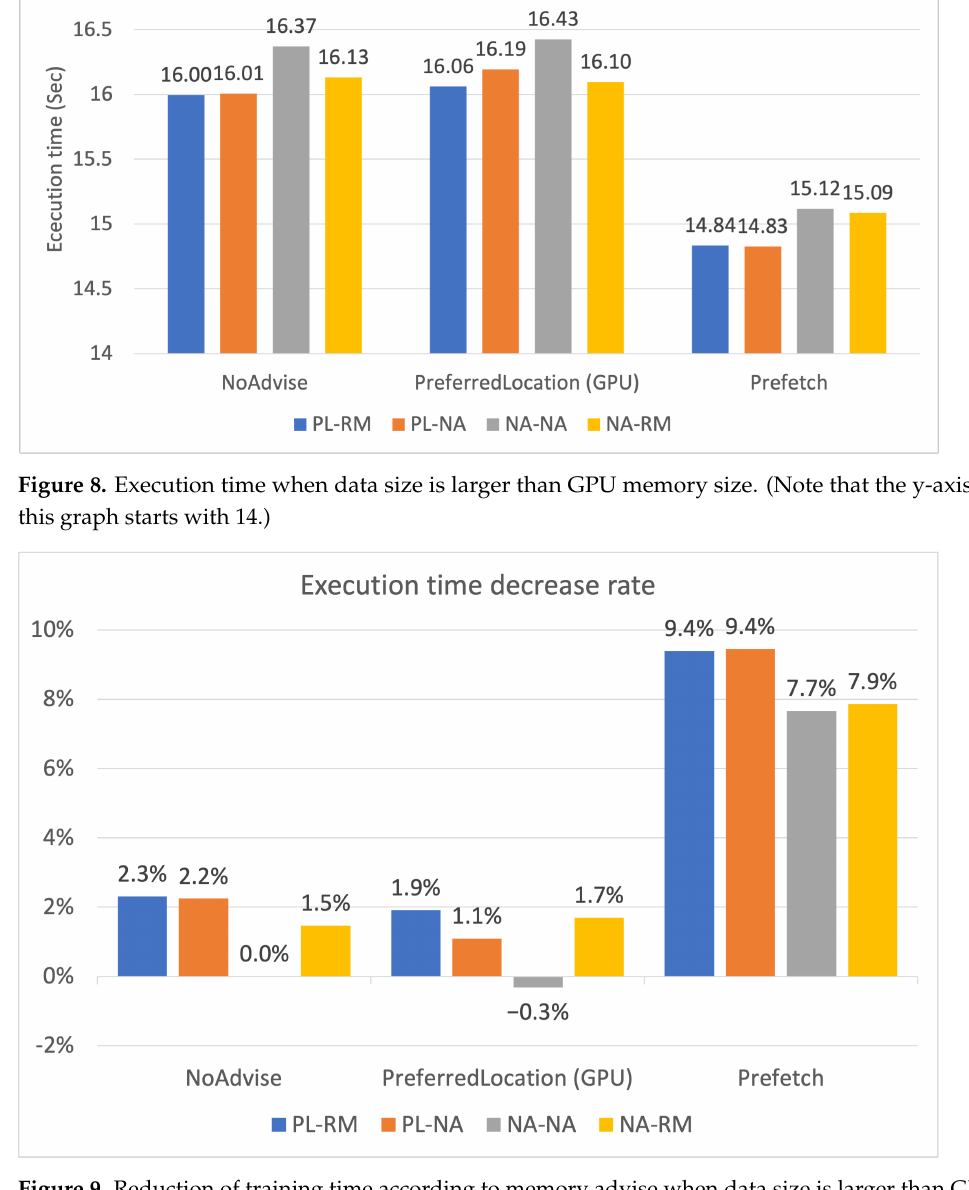
Figure 9. Reduction of training time according to memory advise when data size is larger than GPU